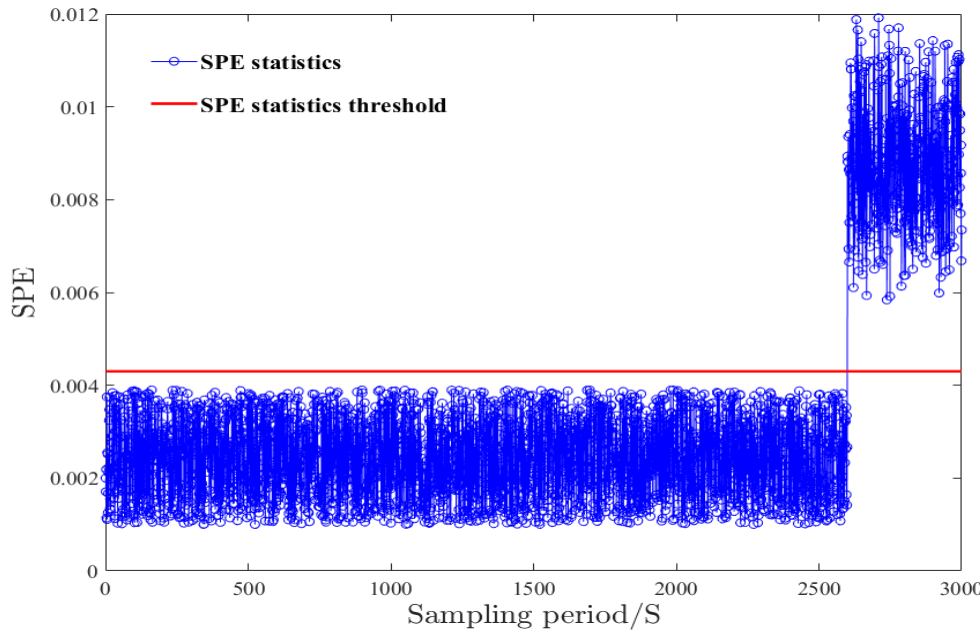
Figure 6. Value of the T 2 statistic under the condition of an LPT fault.